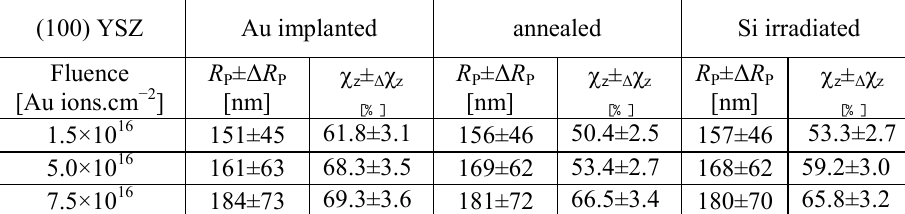
Tab. 1. The mean projected range R P and the standard deviation Δ R P deduce from the experimentally Au concentration-depth profiles from RBS.  z for YSZ implanted with Au-ions, annealed and subsequently irradiated with Si ions are presented in the last